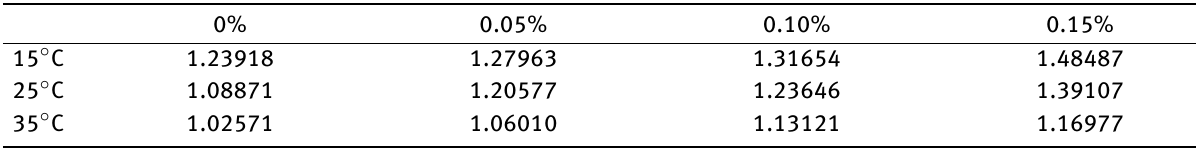
Table 8: ZSV of energetic materials contenting graphene at different temperature ( × 10 6 Pa · s, 1.5mL/g).